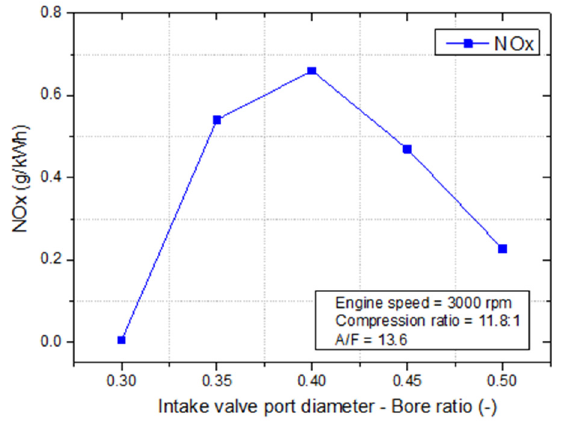
Figure 13. NO x trend versus IPD/B.